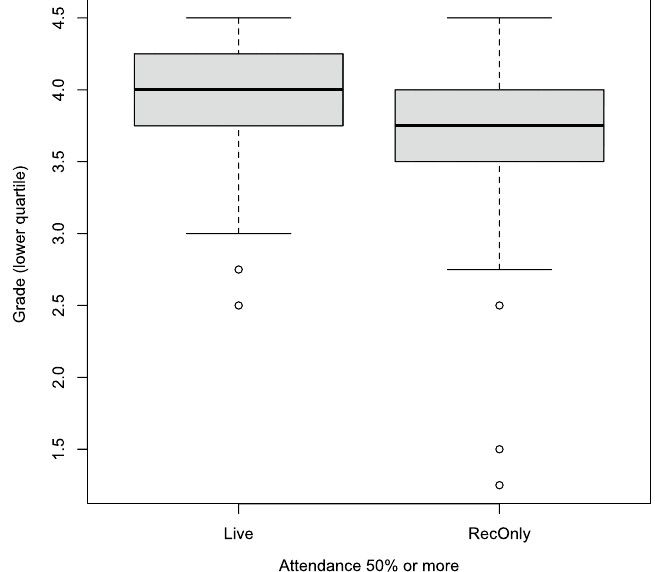
Fig. 5 Boxplot illustrating grade differences of students in the lower performance quartile who followed interactive‑engagement lectures live 50% or more of the time versus students in the lower performance quartile who only watched the recordings 50% or more of the